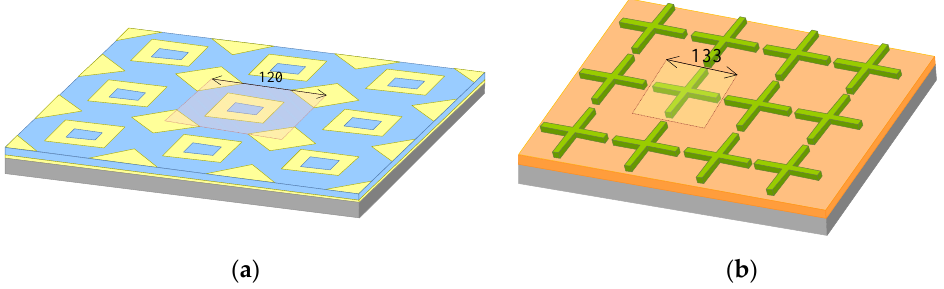
Figure 2. Orthogonal lattice of unit cells for ( a ) SquarePMA and ( b ) CrossPMA with given spatial periods in µm.